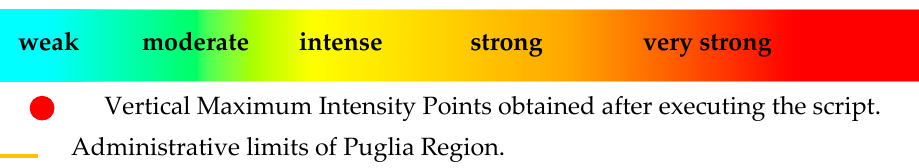
Figure 3. Example of two tests carried out: ( a ) and ( c ) are data from DPC servers, respectively, on